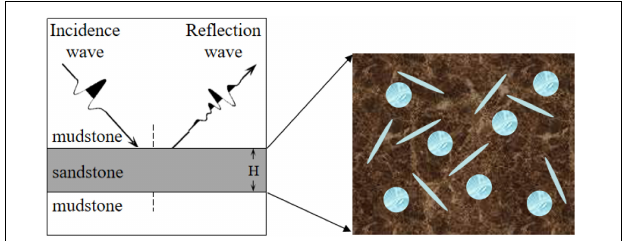
FIGURE 1 | Schematics of the microstructural distributions of stiff and soft pores in tight